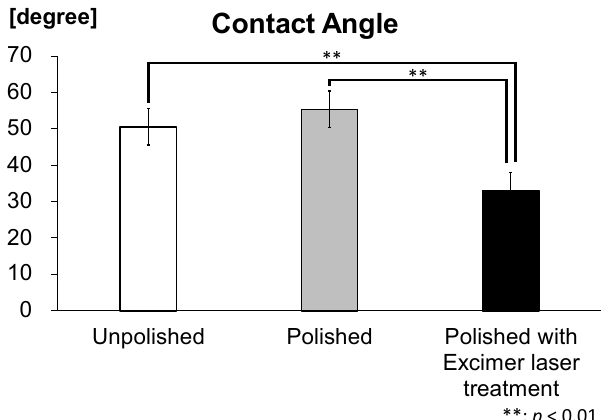
Table 2. Contact angle values of zirconia disks. Data represent means (± SD).